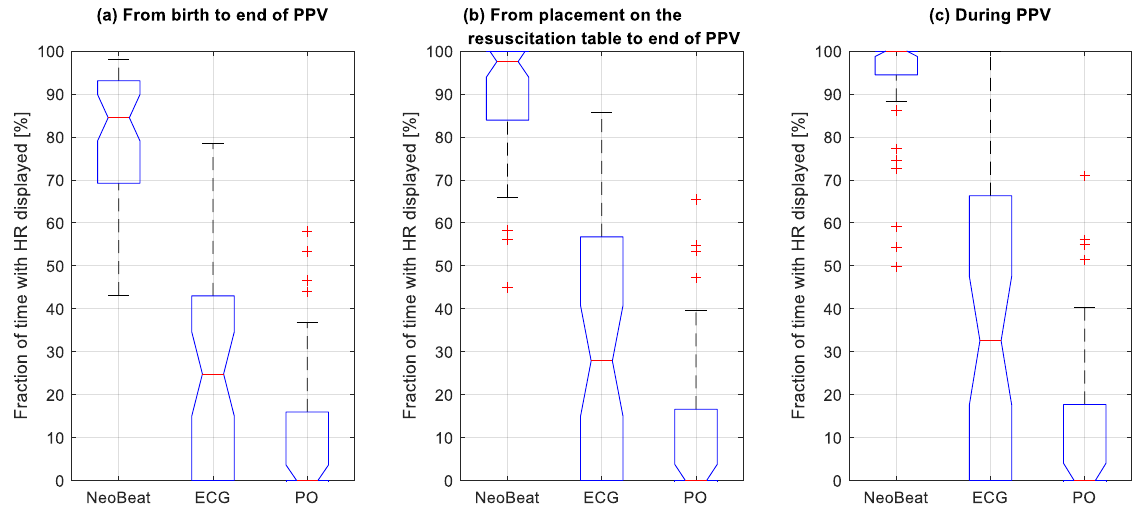
Figure 4. Box plots comparing fraction of time in percentage with heart rate displayed for the three devices among resuscitated newborns, from ( a ) the time of birth, ( b ) placement on the resuscitation table, and ( c ) during positive pressure ventilation. HR, heart rate; PO, pulse oximeter; PPV, positive pressure ventilation. Dots represents outliers.